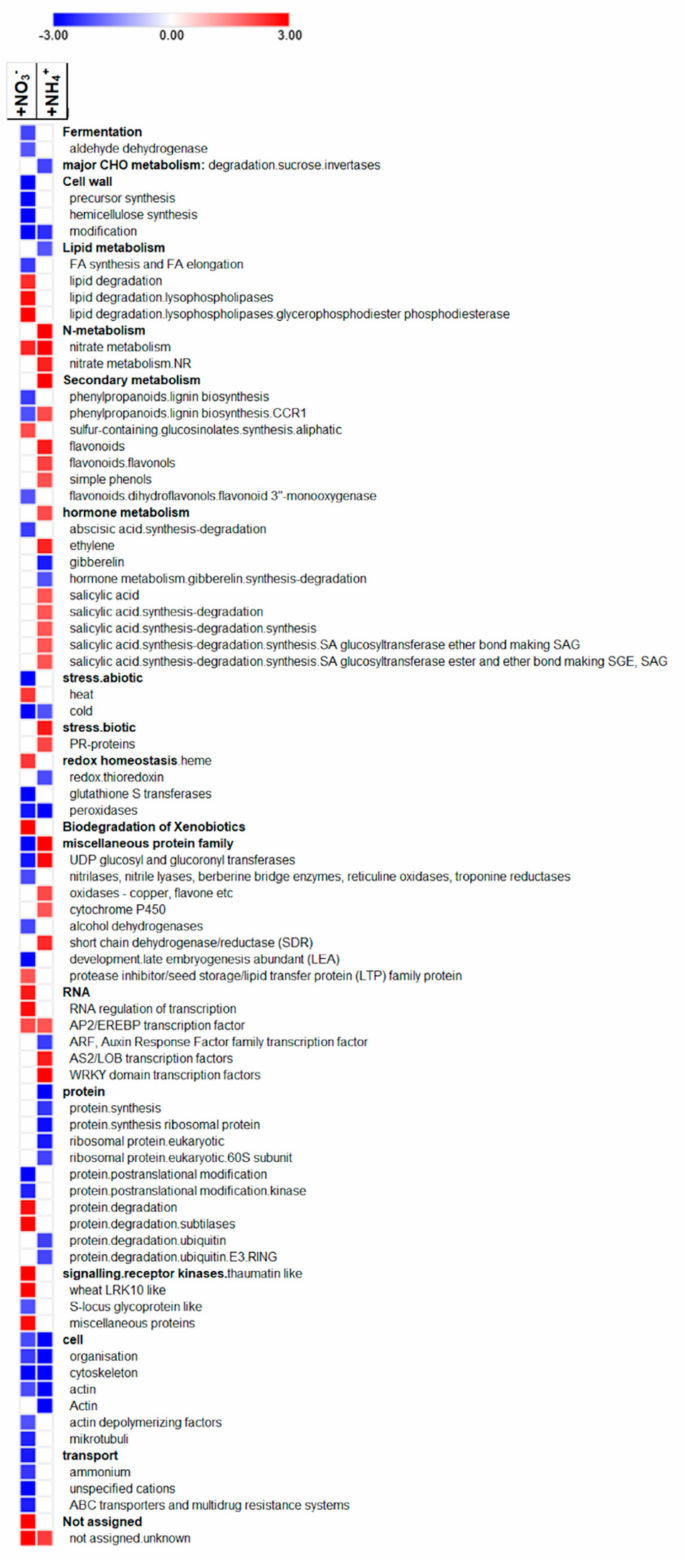
Figure 4. MapMan functional categories enriched of DEGs identified in two treatments ( + NO 3 − / -N; + / -N). Z-scores were deduced from p-values (i.e., 1.96 corresponds to a P-value of 0.05) and + NH 4 are mapped in a blue to red color scale (blue: enrichment among down-regulated DEGs, red: over-representation among up-regulated